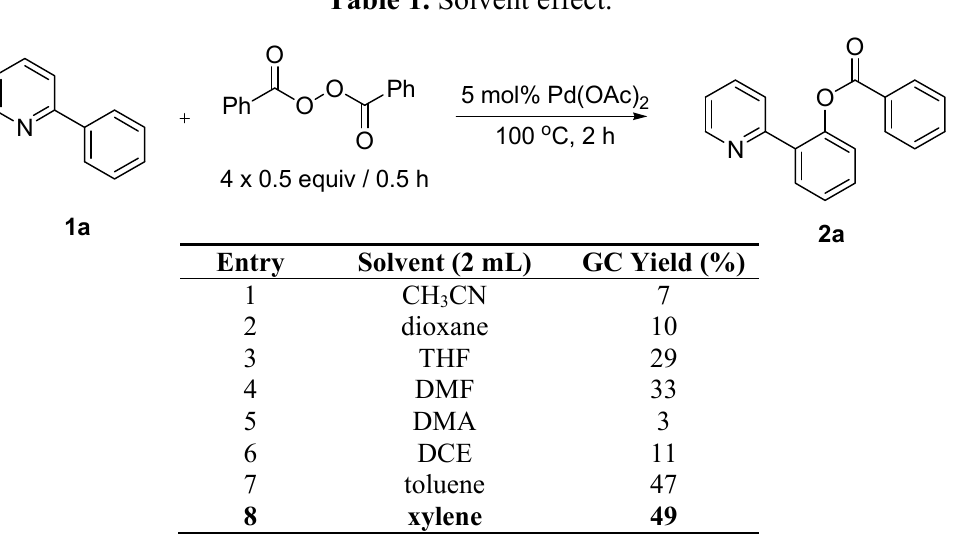
Table 1. Solvent effect.